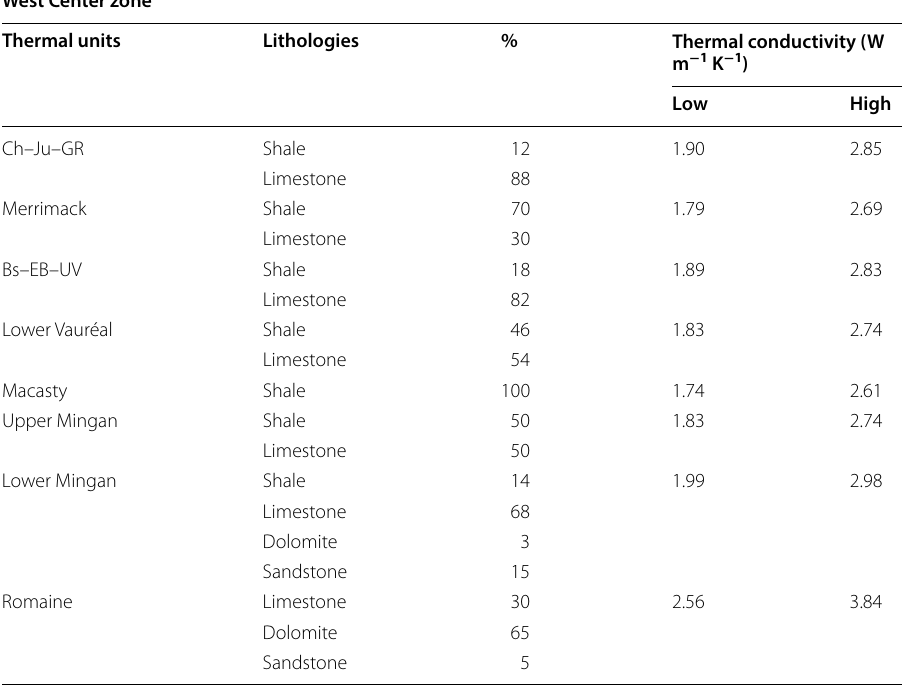
Table 3 Examples of lithological proportion estimates for the West Center zone and resulting thermal conductivity values West Center zone Thermal